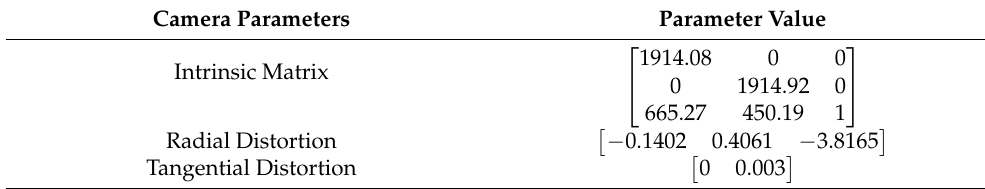
Table 1. Camera calibration results.